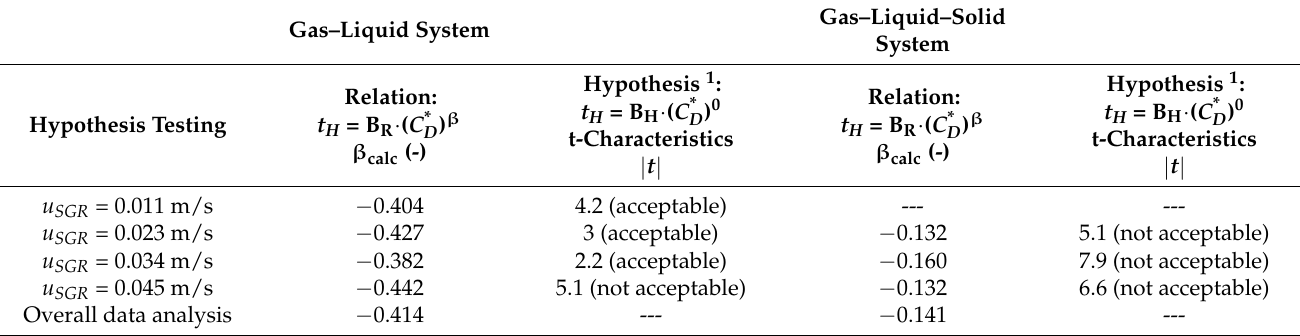
Table 11. Homogenization time t H : Results of the hypothesis testing for effect of deflector clearance C D on superficial gas velocity u SGR =